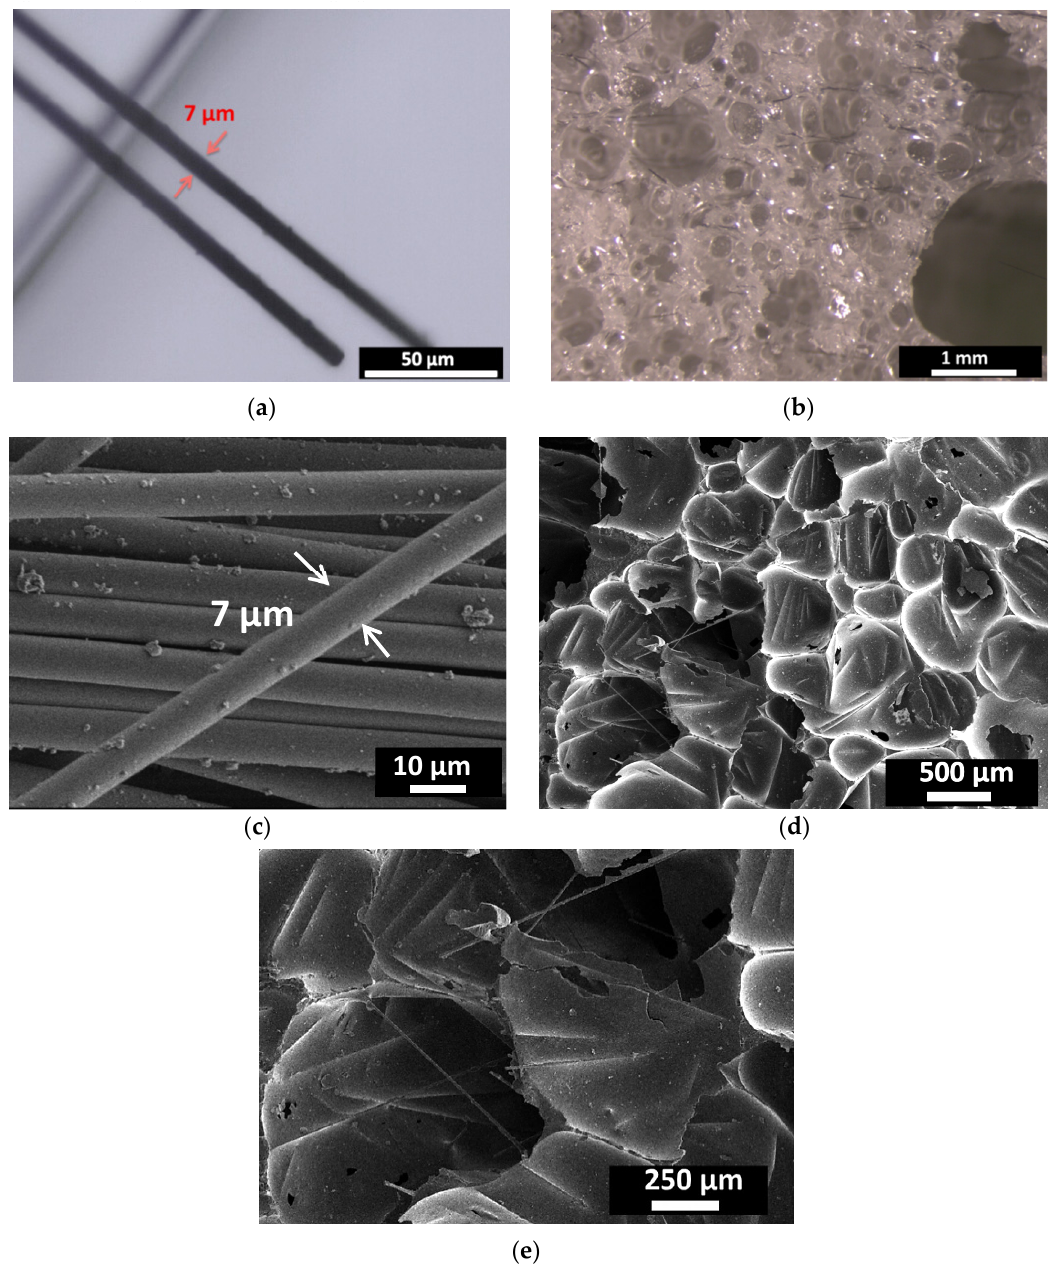
Figure 3. Optical micrographs of ( a ) 3 mm-CFs and ( b ) CFs-loaded epoxy foam, and SEM images of ( c ) 3 mm-CFs, ( d ) and ( e ) CFs-loaded epoxy foam. The presented composite is loaded with 0.5 wt.% of 3 mm-CFs dispersed with spatula.